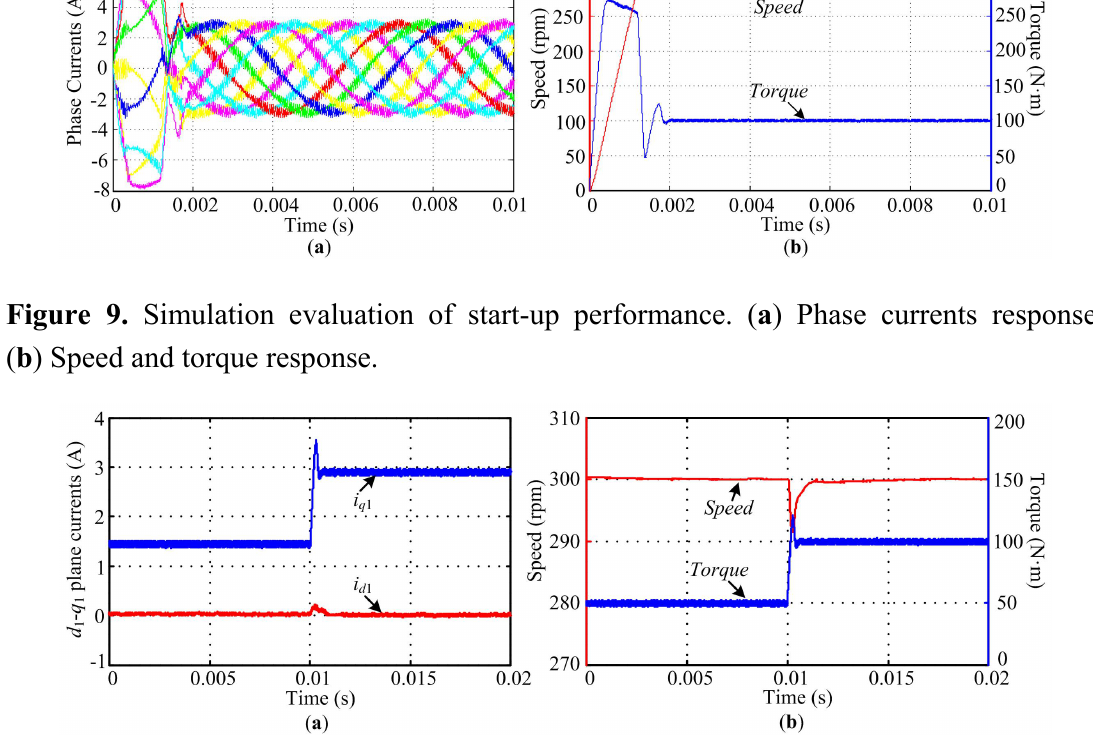
Figure 10. Simulation evaluation of load step change performance. ( a ) d 1 - q 1 plane currents response; ( b ) Speed and torque